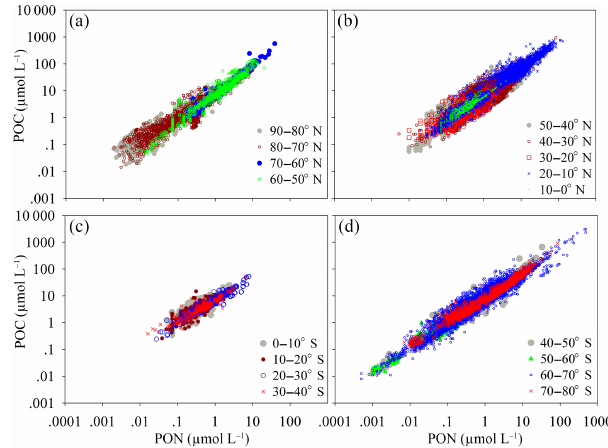
Figure 3. Panels (a, b) are scatter plots of POC and PON for each latitudinal range of the Northern Hemisphere. Panels (c, d) are scat- ter plots of POC and PON for each latitudinal range of the Southern Hemisphere. The relationships between POC and PON are listed in Table